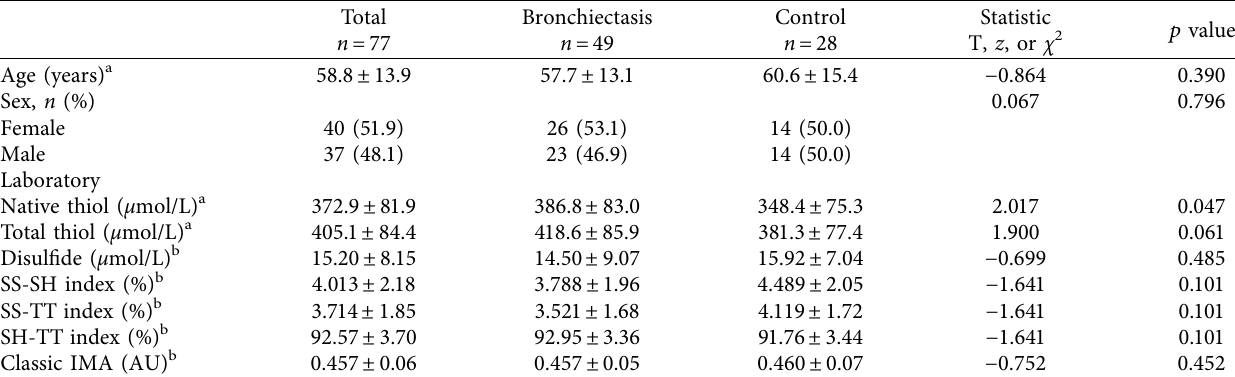
Table 1: Comparison between the data of patients with stable bronchiectasis ( n � 49) and the healthy control group ( n � 28).